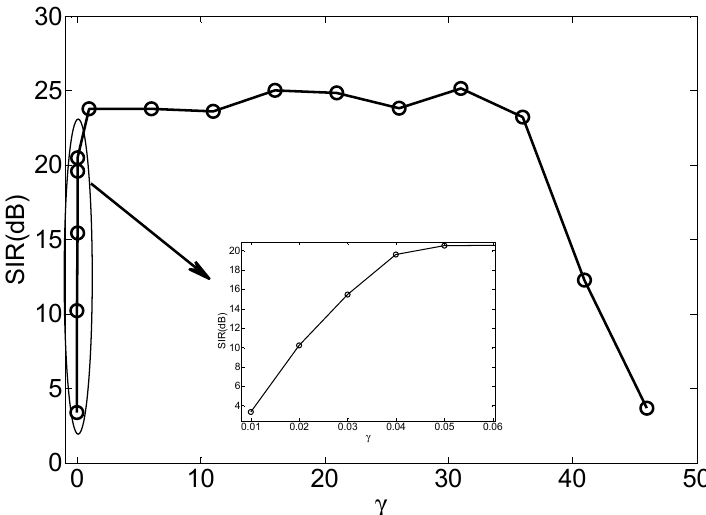
Figure 5. SIRs versus varying threshold γ when λ =